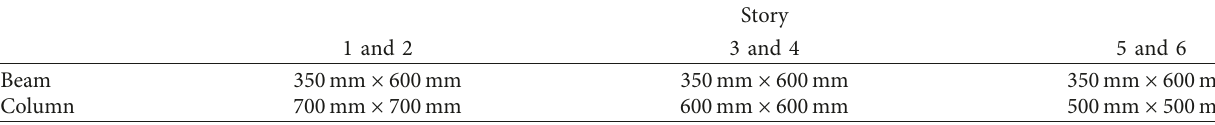
Table 3: Dimensions of member cross sections.